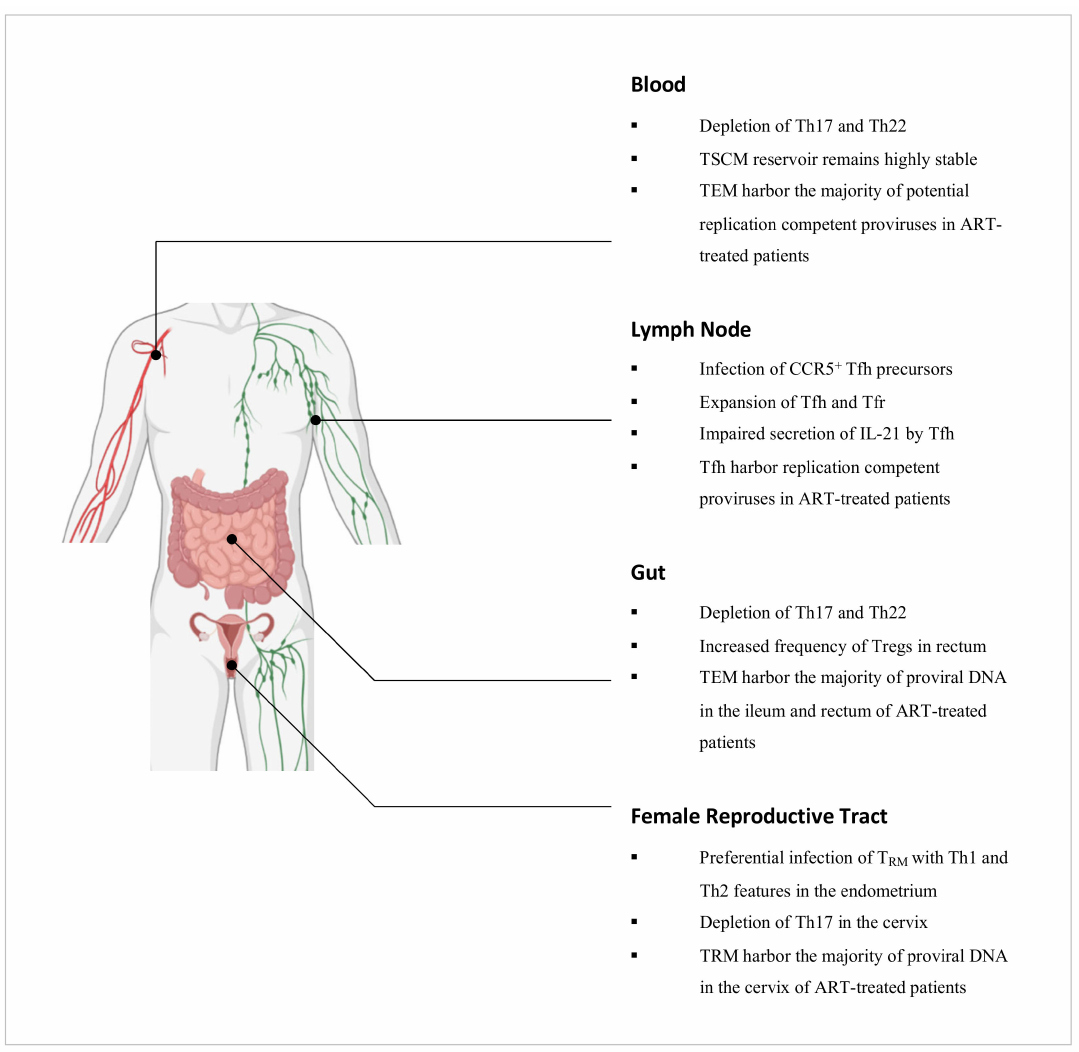
Figure 3. Summary of the key dynamics amongst CD4 + T cell subsets during HIV infection in relevant anatomical compartments. Figure created with